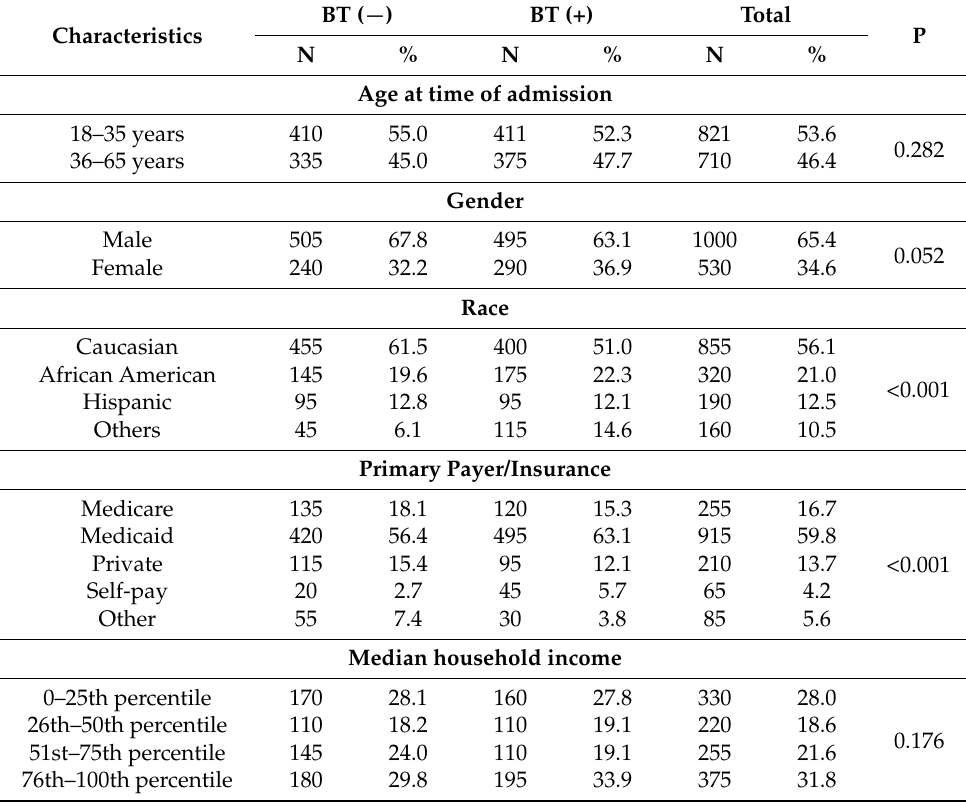
Table 1. Demographic distribution of patients by